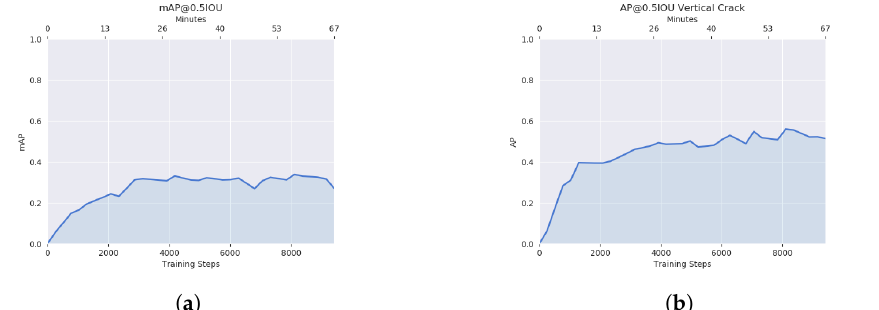
Figure 7. mAP and AP of the ‘vertical crack’ in Model 1. ( a ) Mean average precision. ( b ) Average precision of the ‘Vertical Crack’.